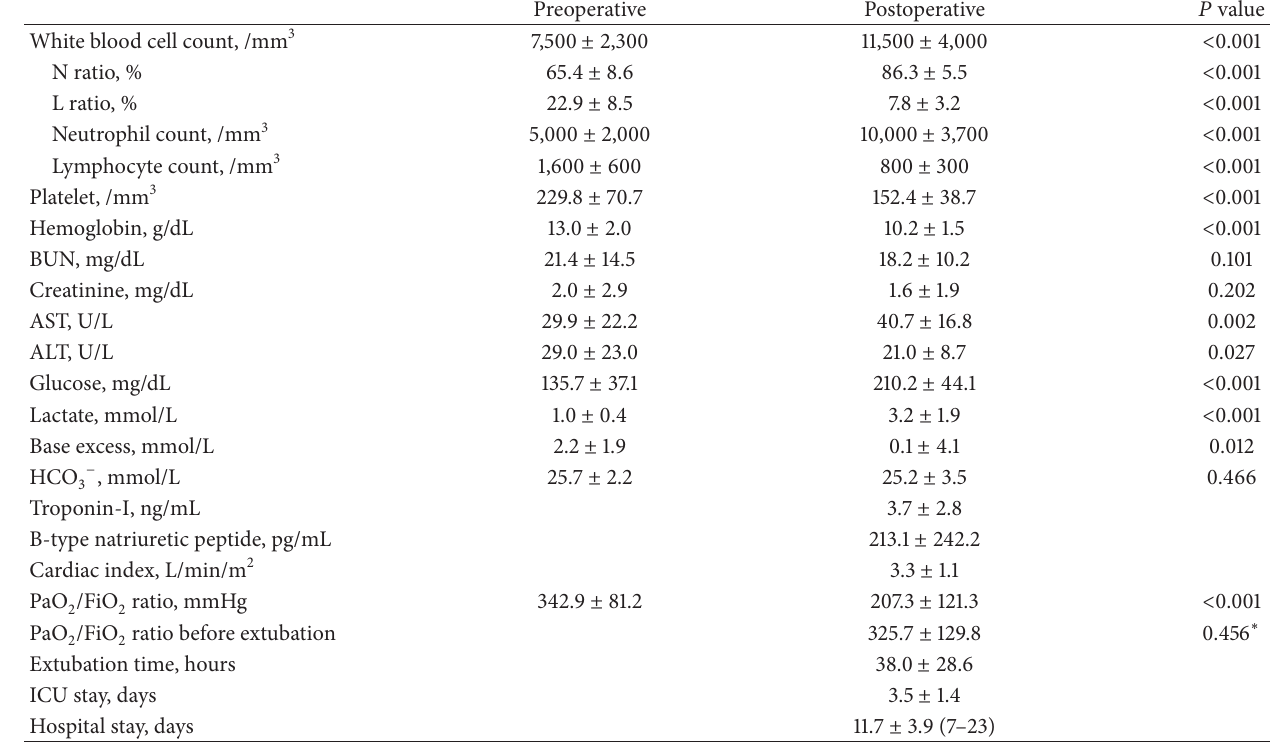
Table 2: Perioperative laboratory data and